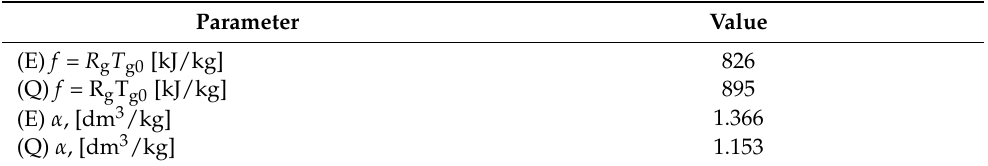
Table 2. Estimated equation of state parameters for propellant